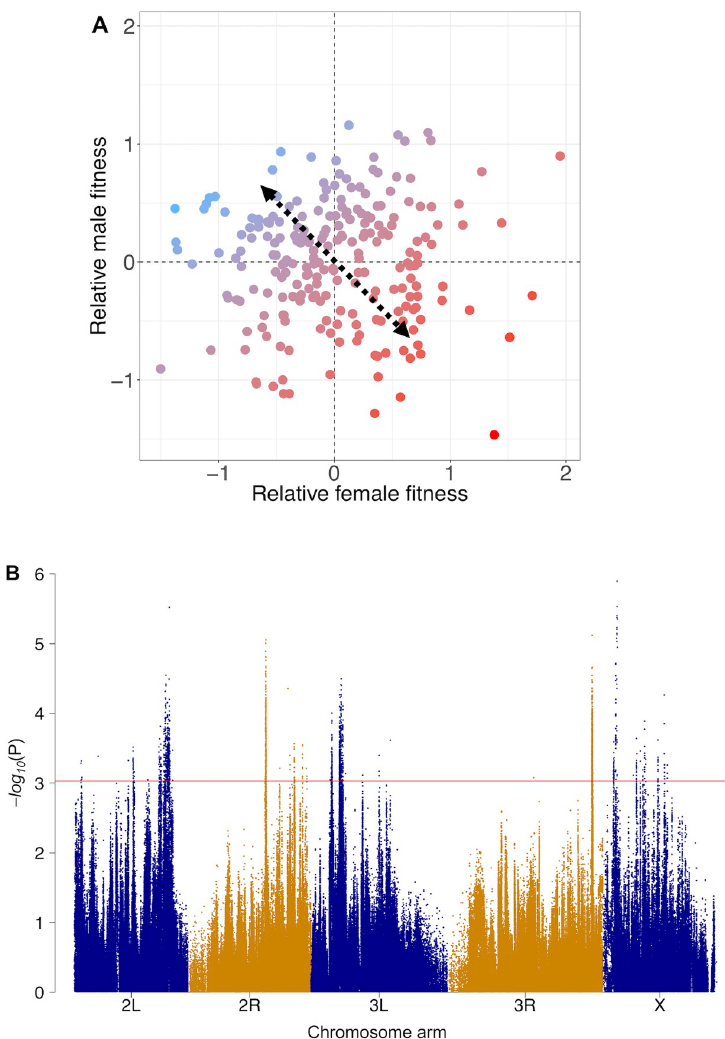
Fig 1. Genome-wide association mapping of sexual antagonism. (A) Relative male and female lifetime reproductive fitness estimates for 223 D . melanogaster hemiclonal lines. Fitness measures have been normalised, scaled, and centred (see Materials and methods). Colours denote each line’s antagonism index, i.e., their position along a spectrum (dashed arrow) ranging from male-beneficial, female-detrimental fitness effects (blue) to female-beneficial, male- detrimental effects (red). (B) Association of each SNP with the antagonism index along the five major D . melanogaster chromosome arms, presented as a Manhattan plot in which each point represents the − log 10 (P) value from a Wald w 2 association test. Colours denote chromosome arms; the horizontal line represents the Q-value cutoff (0.3) used to define candidate antagonistic SNPs. Data and code underlying this figure can be found at https://doi.org/10.5281/ zenodo.2623225. SNP, single nucleotide polymorphism.